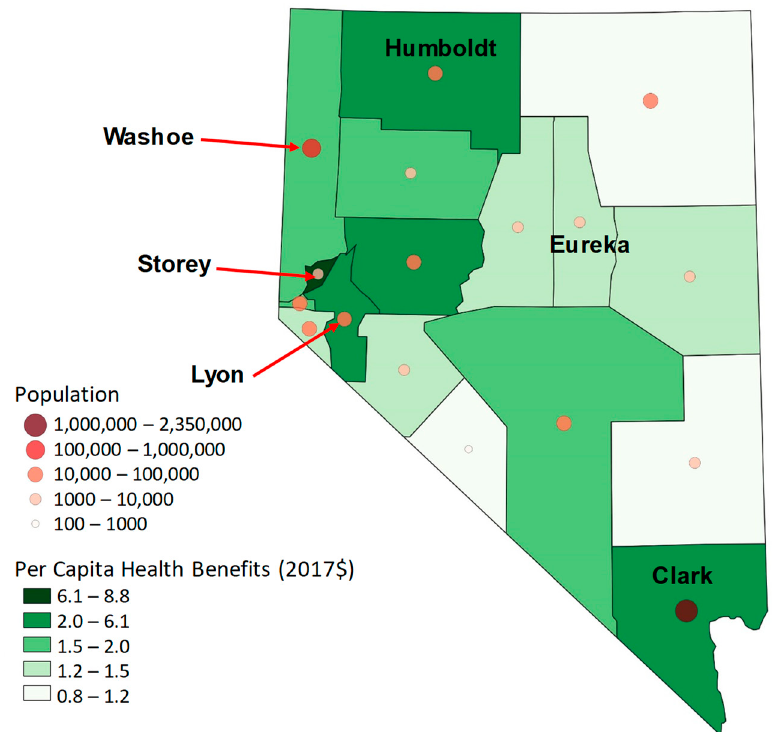
Figure 3. Distribution of population and per capita health benefits across Nevada counties. Clark, Eureka, Humboldt, Lyon, Storey, and Washoe counties are noted.